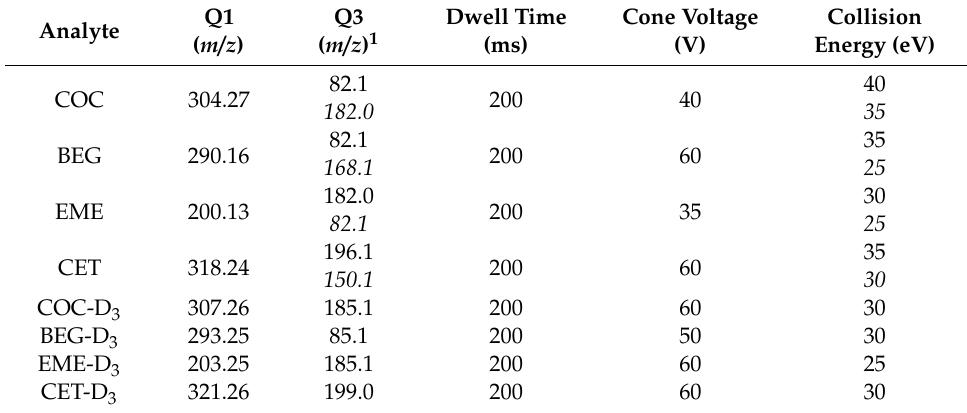
Table 5. Multiple reaction monitoring (MRM) transitions and compound-specific MS